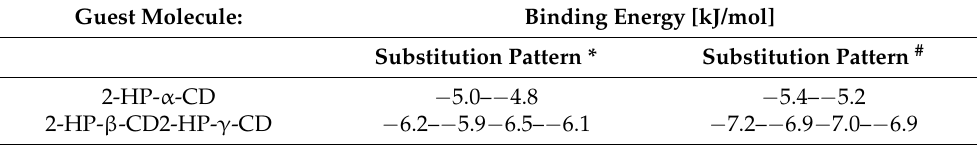
Table 1. The energy of binding determined for different types of RA–CD systems. Due to the high conformational flexibility of both guest and host molecules, minor differences in determined energies for various poses, as well as the equivalency of different binding poses, the given energy ranges correspond to systems of similar structural geometries. #: 2-HP-CD # containing all 2-HP groups substituted to the O (2) hydroxyl oxygen atoms of CD (atom numbering in accordance with the IUPAC recommendations); *: 2-HP-CD* containing all 2HP groups substituted to the O (6) hydroxyl oxygen atoms of the hydroxymethyl groups present in CD.